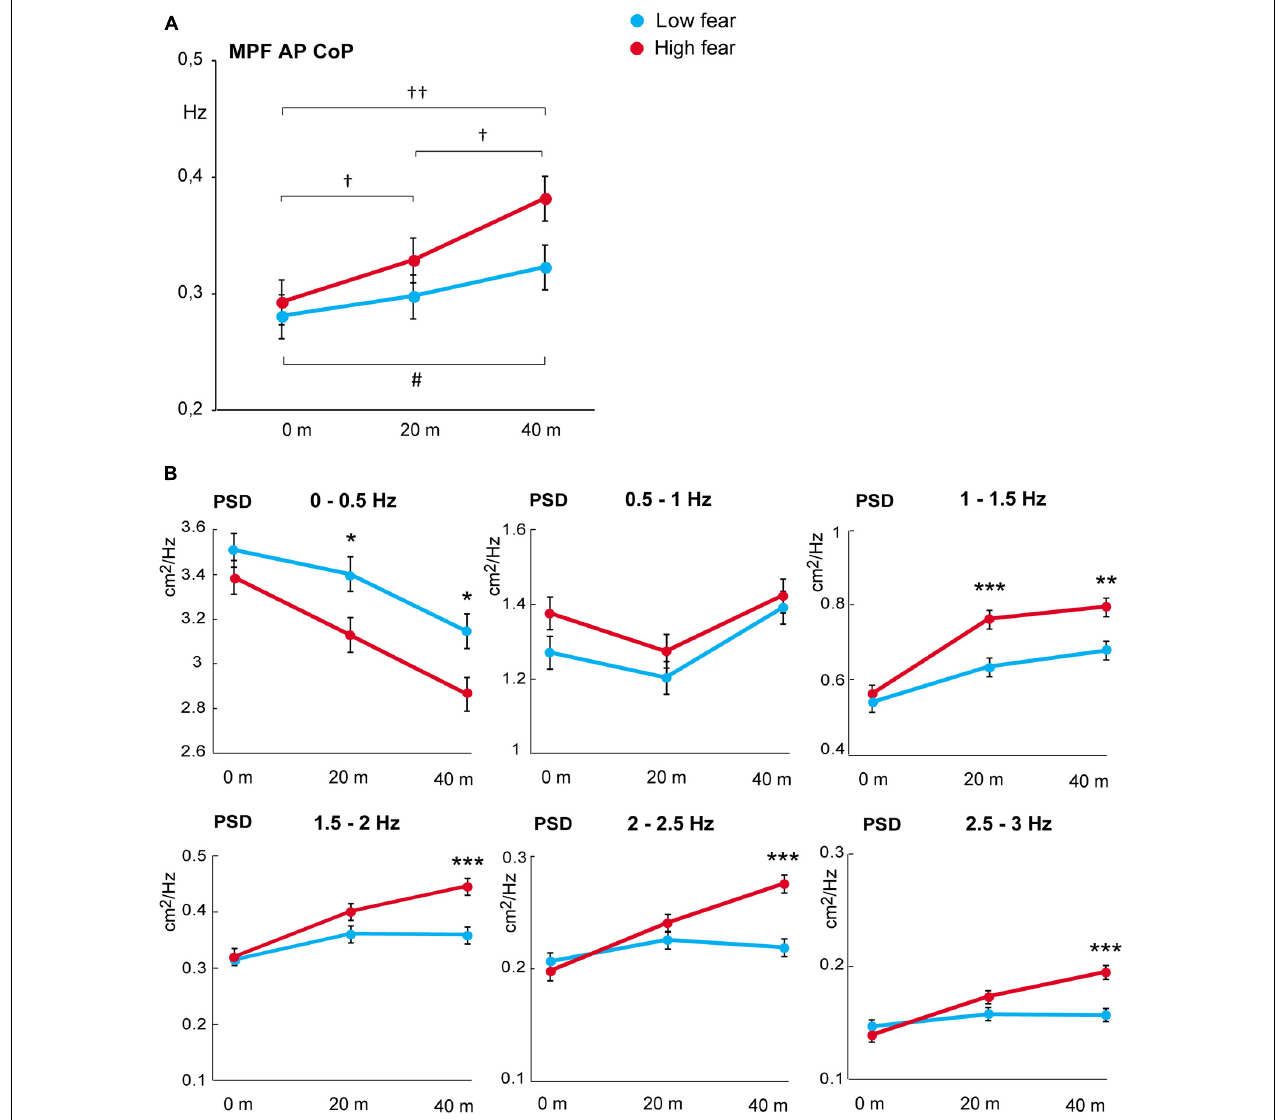
FIGURE 4 | (A) Mean power frequency score of CoP displacement in anterior–posterior direction (estimated marginal means ± SEM). Significant differences between heights 0 versus 20 m, 0 versus 40 m, and 20 versus 40 m are marked as follows: # p < 0.05 for the low fear group and † p < 0.05, †† p < 0.01 for the high fear group. (B) Power spectral density of CoP displacement in anterior–posterior direction (estimated marginal means ± SEM) in six frequency bands at virtual heights of 0, 20, and 40 m in the low and high fear groups. Significant differences between groups are marked as follows: * p < 0.05, ** p < 0.01, *** p <